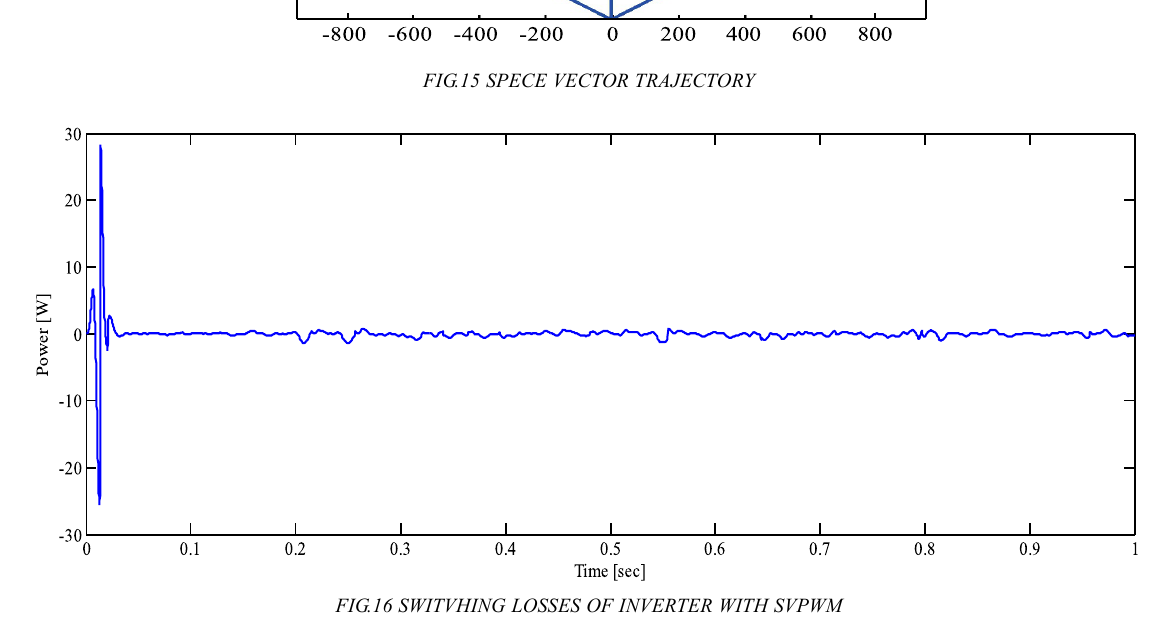
FIG.16 SWITVHING LOSSES OF INVERTER WITH